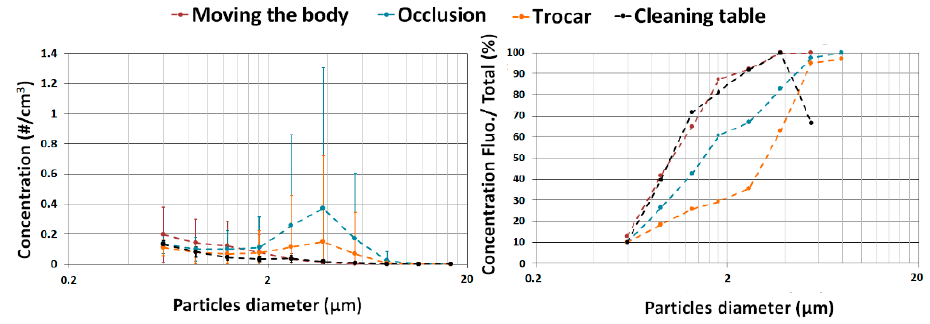
Figure 7. Fluorescent particle concentration ( left ) and fluorescent fraction ( right ) by particle size for the three most emissive tasks observed in lab C. (#/cm 3 : number of particles per cm 3 of air).